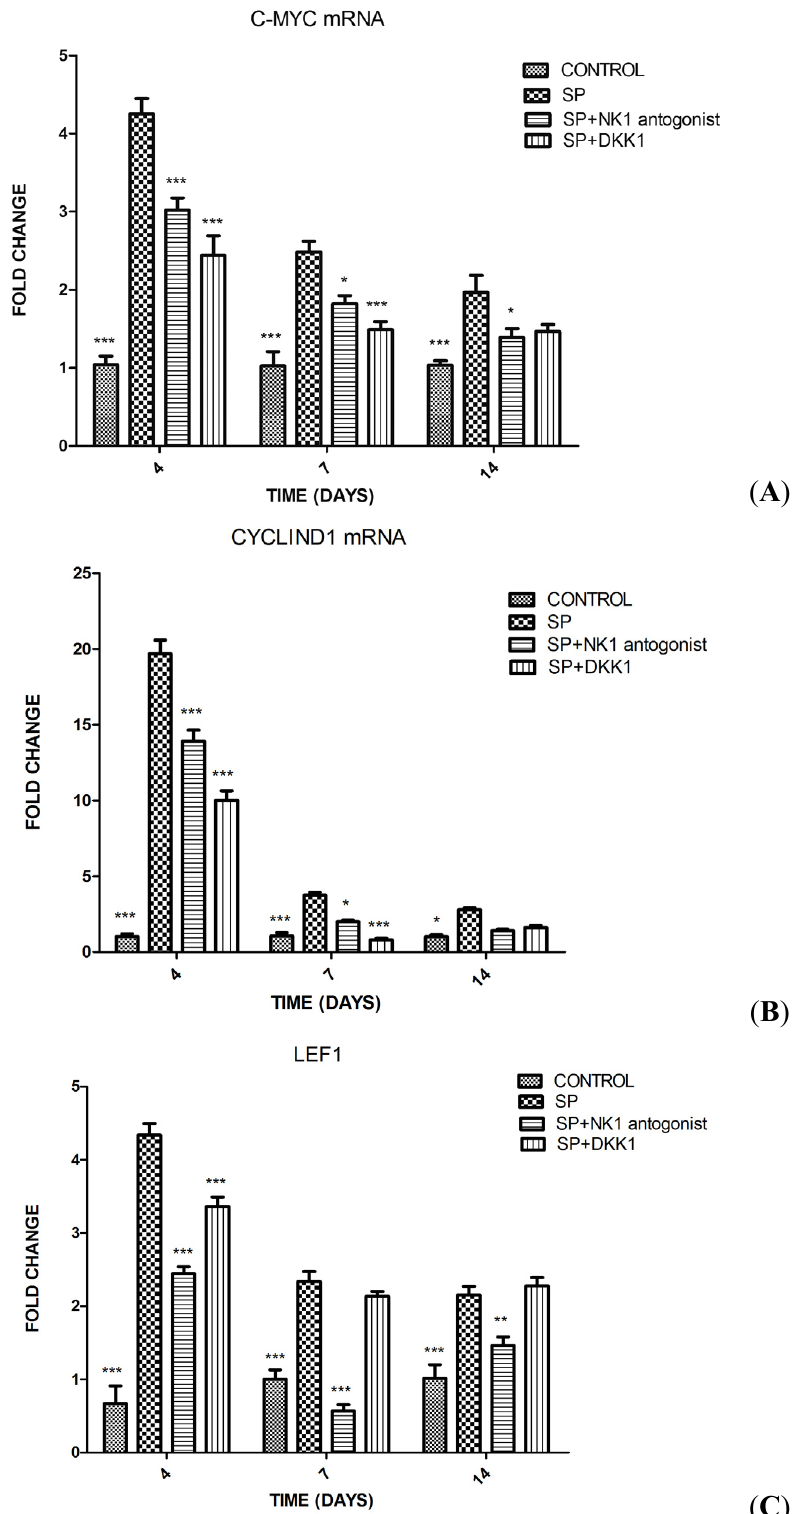
Figure 4. Effects of SP, SP + NK1 antagonist, SP + DKK1 and the same amount of PBS on days 4, 7, 14 on gene expressions in MC3T3-E1 cells measured by qPCR. ( A ) c-myc mRNA; ( B ) cyclin D1 mRNA; ( C ) Lef1 ; ( D ) Tcf7 ; and ( E ) β -catenin mRNA. Results are representative of 3 independent experiments. * p < 0.05 versus SP; ** p < 0.01 versus SP; and *** p < 0.001 versus SP,